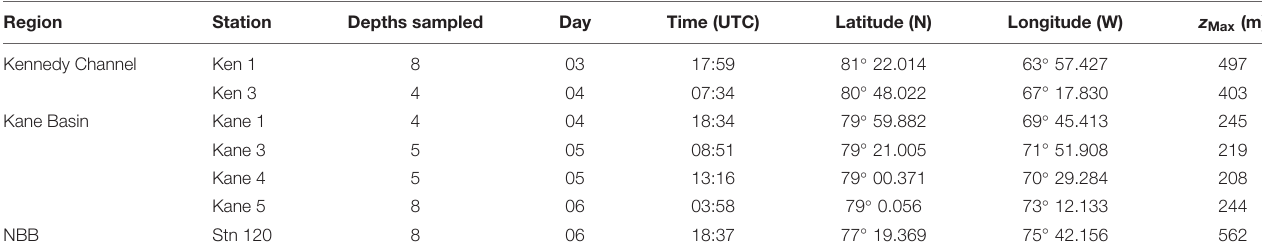
TABLE 1 | Station location, day, and time of sampling in August 2014. Region Station Depths sampled Kennedy